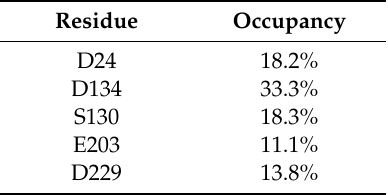
Table 2. Summary of the iron occupancy around residues during the